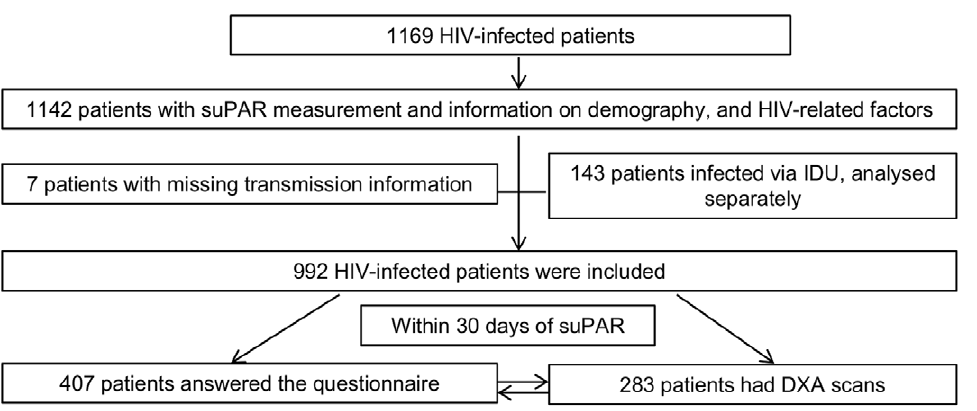
Figure 1. Flow chart of study cohort. 235 patients had both been DXA-scanned and answered the questionnaire. Abbreviations: DXA: Dual Energy X-ray Absorptiometry; IDU: Intravenous drug use; suPAR: soluble urokinase plasminogen activator